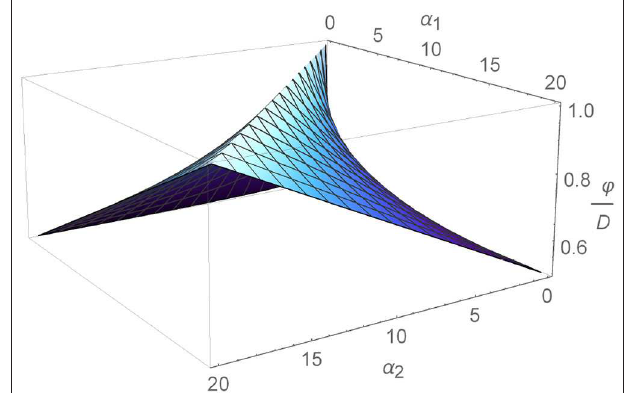
( ααα ) in the two-miner FIGURE 3 | ϕ D